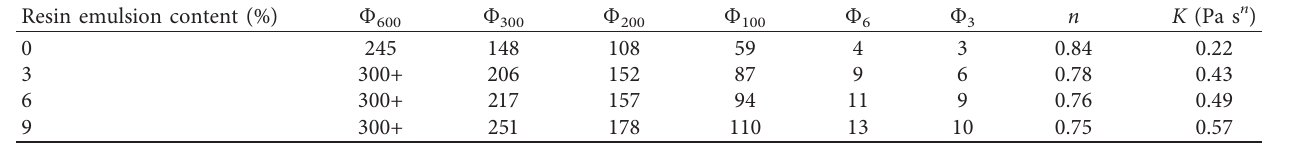
Table 2: Rheology of resin emulsion cement slurry.